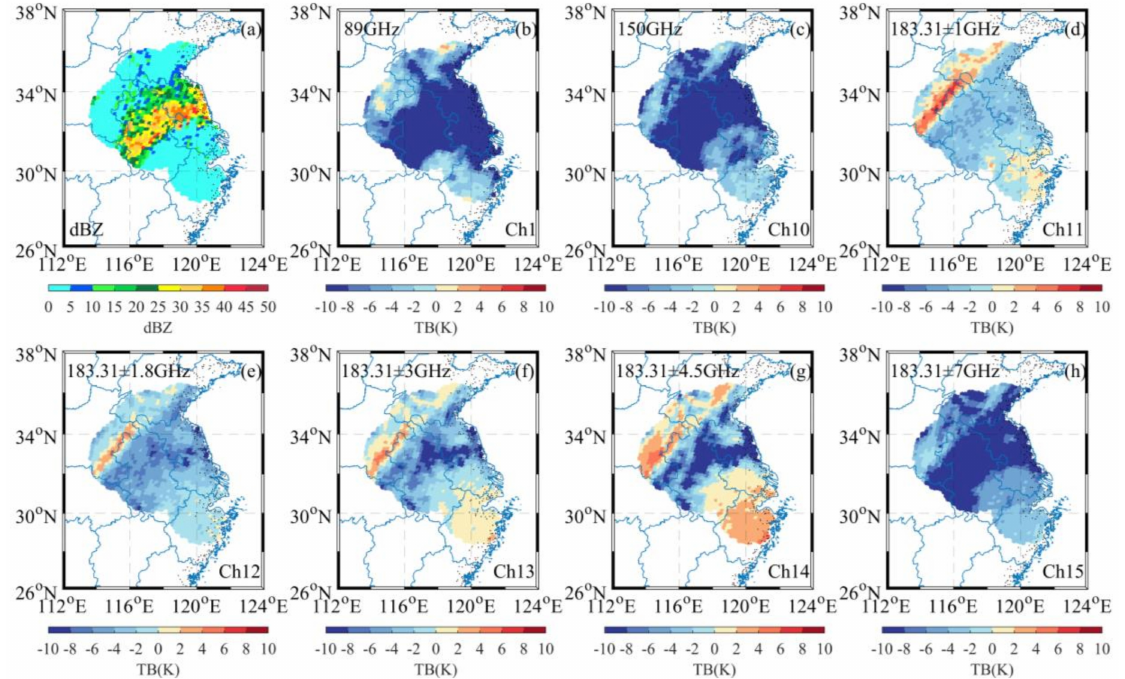
Figure 9. Spatial distribution of ground-based radar reflectivity ( a ), and O − B for window channels ( b , c ) and humidity-sounding channels ( d – h ) on 4 July 2016.